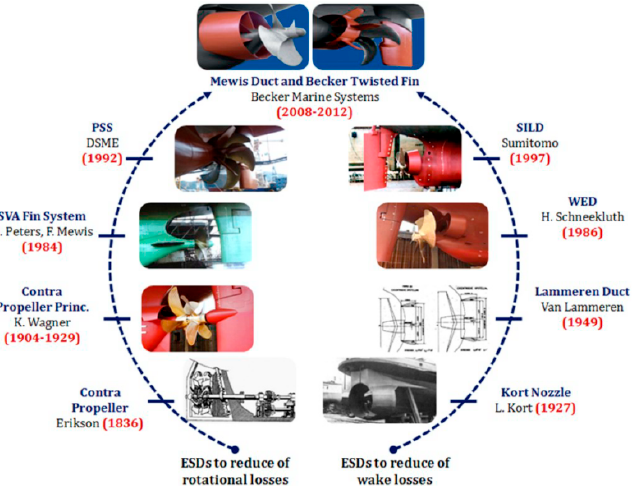
Figure 3. History of Mewis duct ® and Becker twisted fins ® (Becker Marine Systems GmbH & Co. KG, Hamburg, Germany) [24].